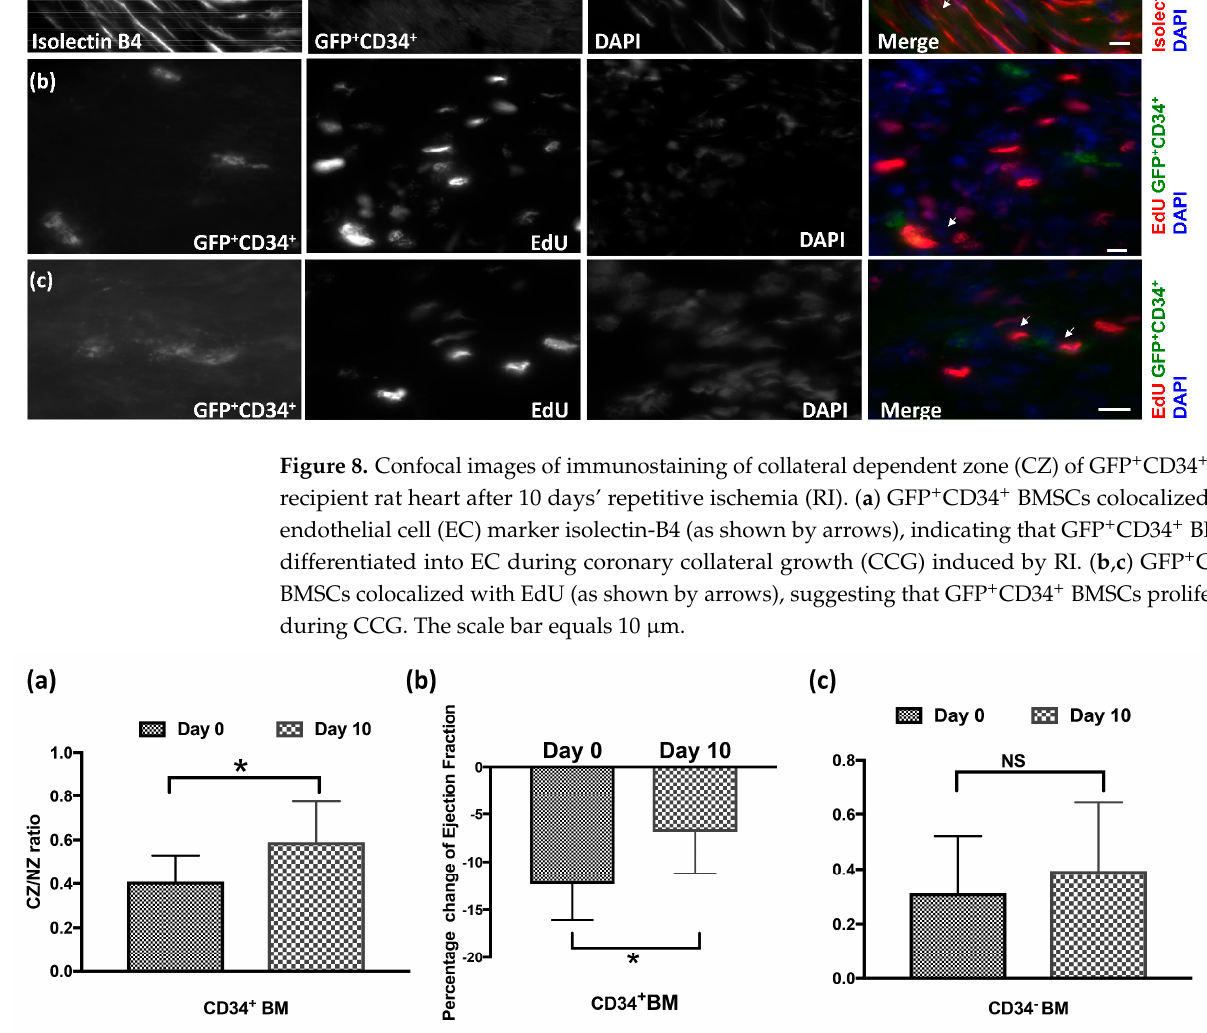
Figure 9. CD34 + BMSCs contributed to coronary collateral growth. ( a ) shows the change of coronary blood flow measured by contrast echo during inflation of the occluder in the normal zone (NZ) and collateral dependent zone (CZ) in CD34 + BMSC recipient rats at day 0 (before RI) and day 10 (after RI), suggesting coronary collateral growth. * p < 0.05 ( b ) shows the ejection fraction change from day 0 to day 10 of RI with occluder inflation, suggesting improved cardiac function and, therefore, coronary collateral growth in CD34 + BMSC recipient rats. * p < 0.05 ( c ) shows no significant change in CZ/NZ blood flow ratio in CD34 − BMSC recipient rats between day 0 and day 10, suggesting no coronary collateral growth. NS = not